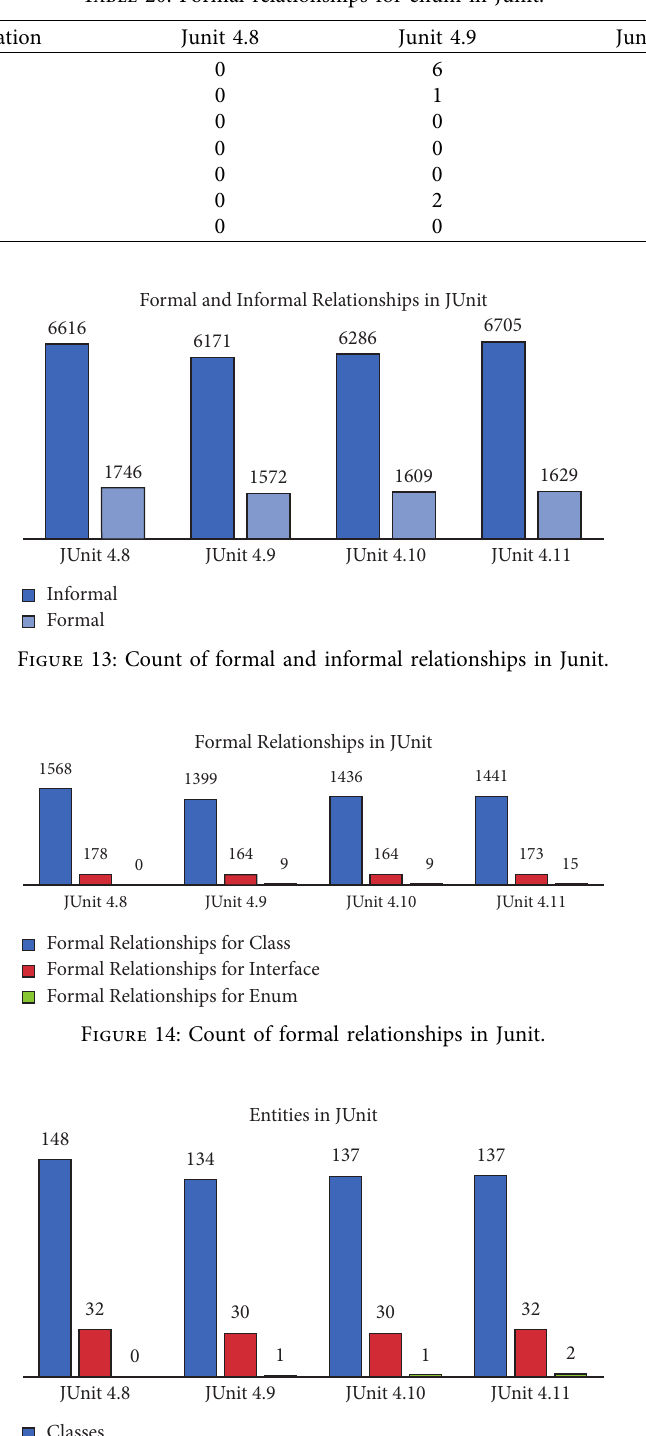
Table 20: Formal relationships for enum in